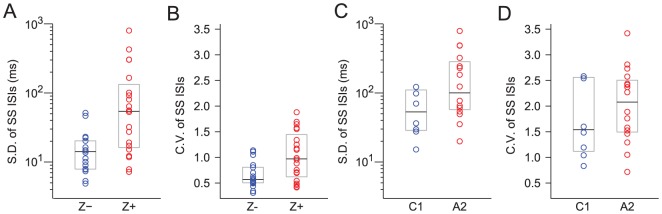
Z− PCs have more regular SS trains than do Z− PCs.Plots of the SD (A) and CV (B) of the ISI distributions for SS trains from Z+ and Z− PCs. Analogous plots for the zonal data are shown in (C) and (D). In each plot data the circles represent values from individual PCs, the horizontal lines show the medians of the various distributions, and the boxes indicate the interquartile ranges.